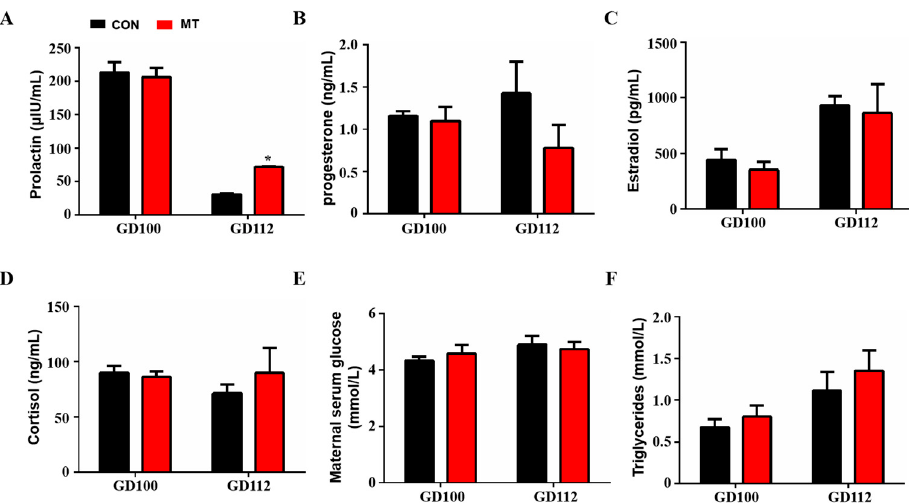
Figure 3. Effects of melatonin supplementation on blood hormone and other biochemical indices.